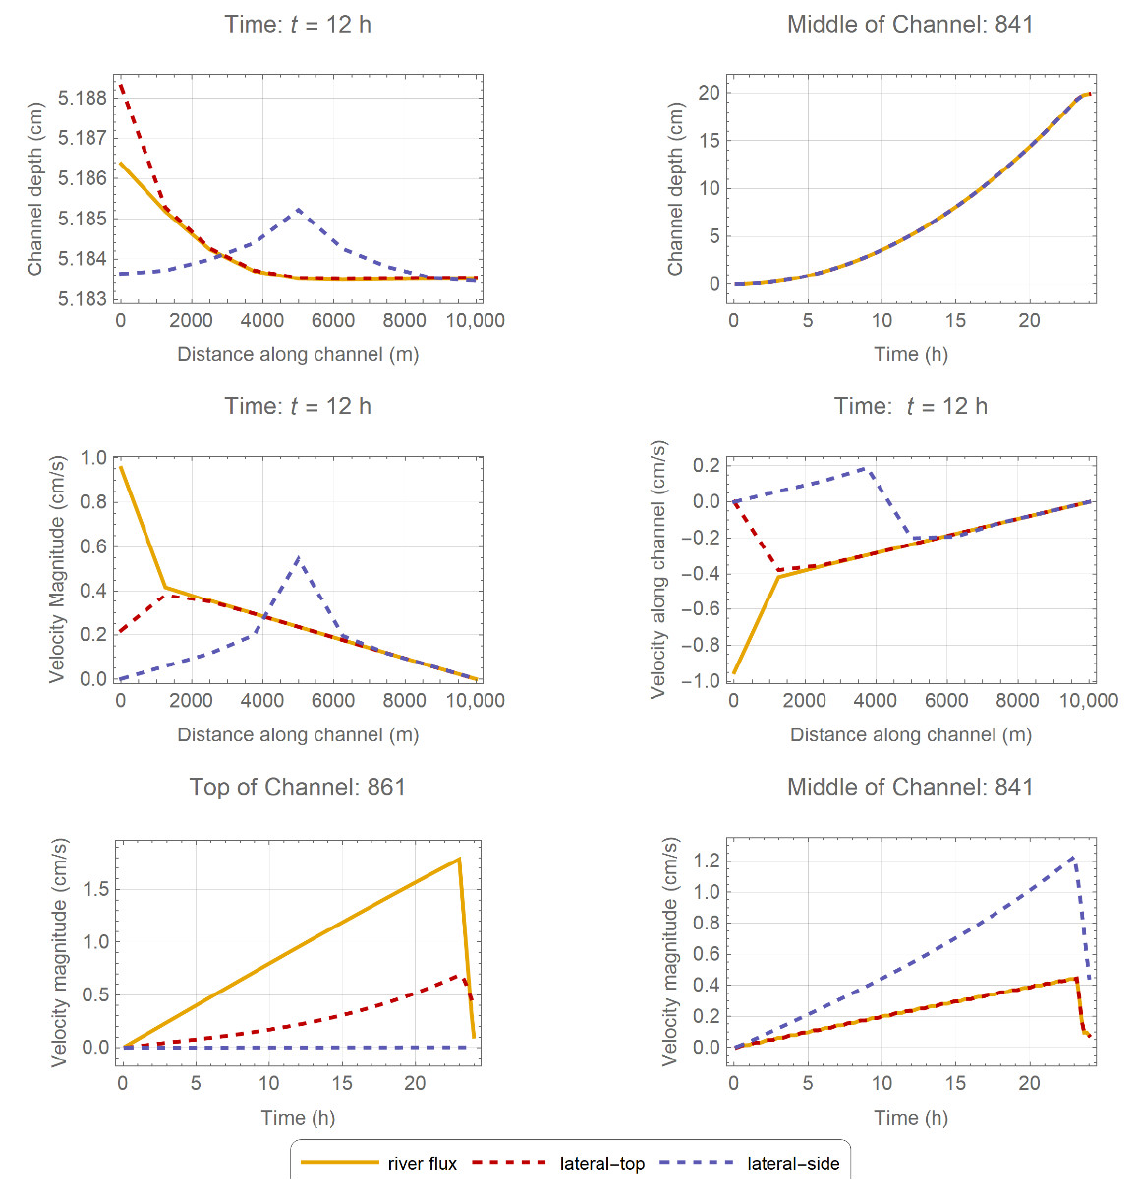
Figure 5. Elevation and velocity channel profiles at time t = 12 h and timeseries at the ideal test case input locations (top and middle of the channel) for the three different forcing mechanisms: river flux boundary condition, lateral inflow at the top of the channel and lateral inflow from the side (at the middle of the channel domain).